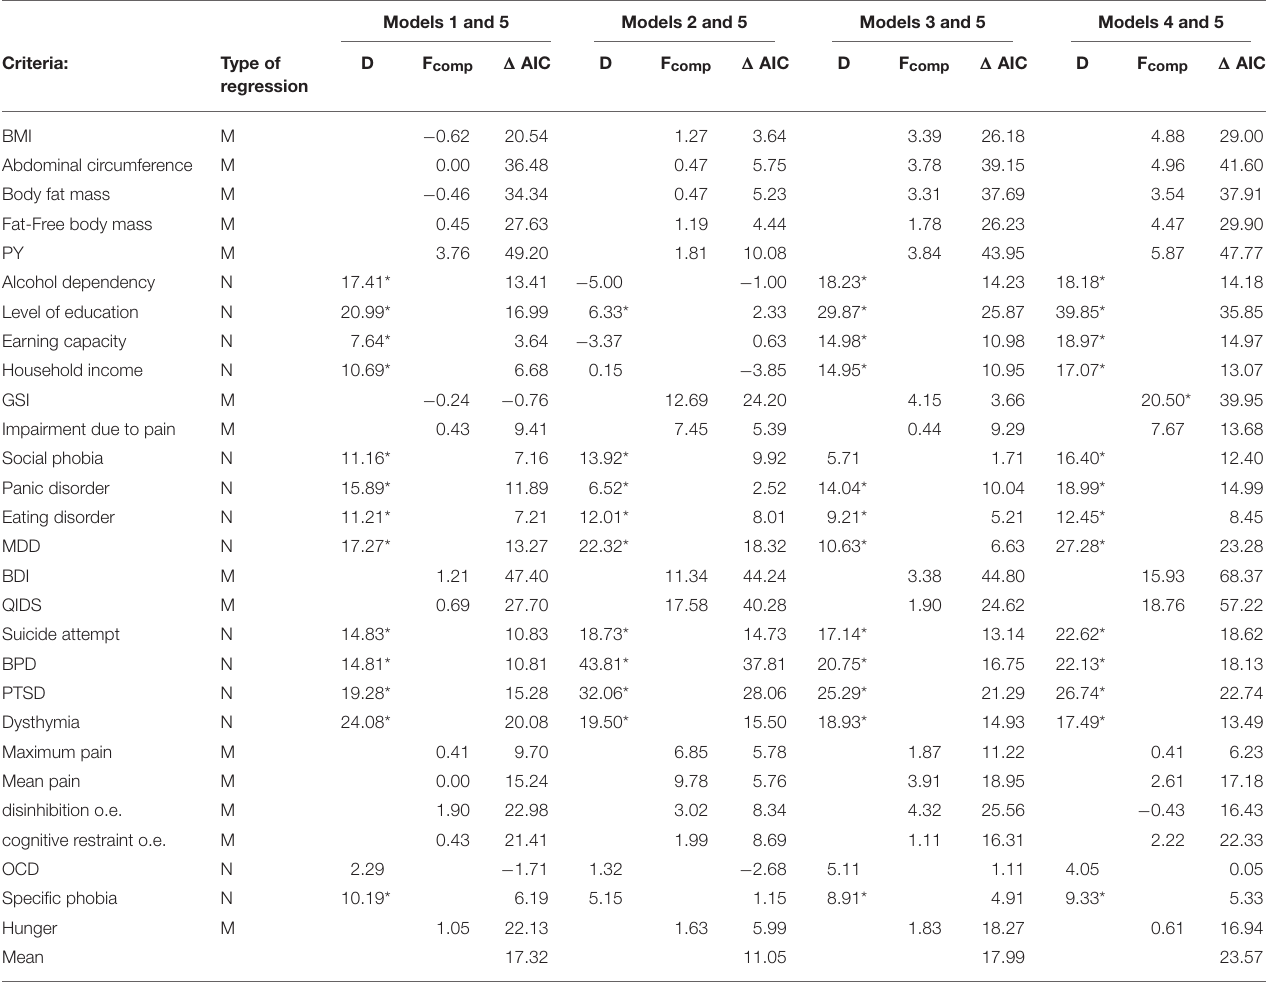
TABLE 5 | Comparison of the cumulative and selective approach with the dimensional approach. Models 1 and 5 Models 2 and 5 Models 3 and 5 Models 4 and